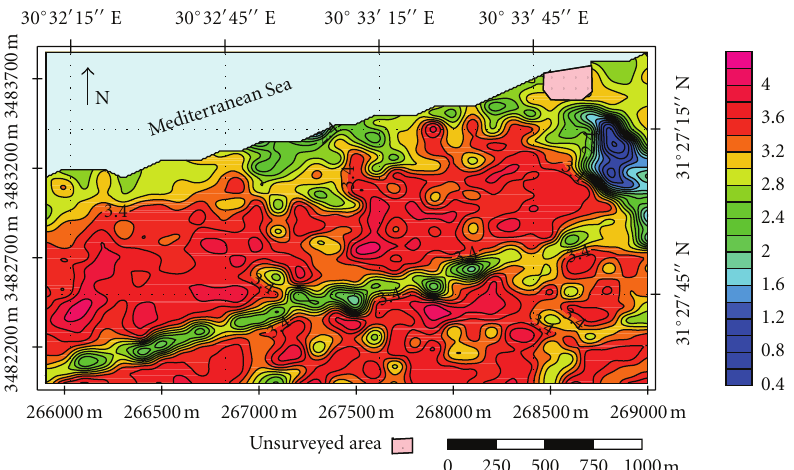
Figure 14: Filled colour contour map of the calculated metal factor (MF) values from laboratory measurements, Koam Mashaal area, East Rosetta, Mediterranean Sea Coast, Northern Egypt. Logarithmic contour interval =